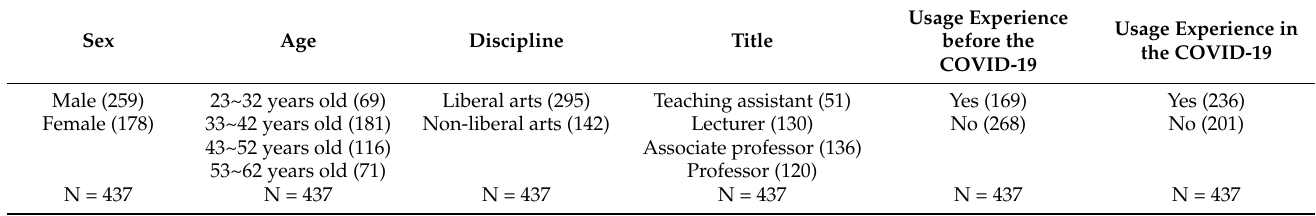
Table 10. Frequency statistics of control variables.